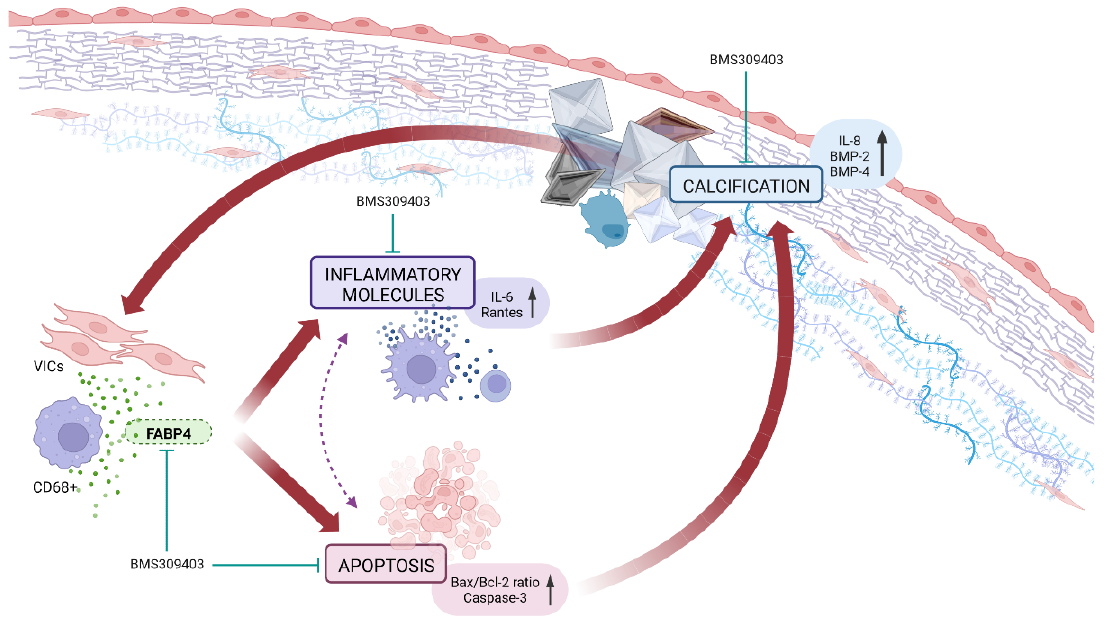
Figure 5. The pharmacological inhibition of FABP4 improved the VICs’ inflammation, apoptosis, and calcification in AS.